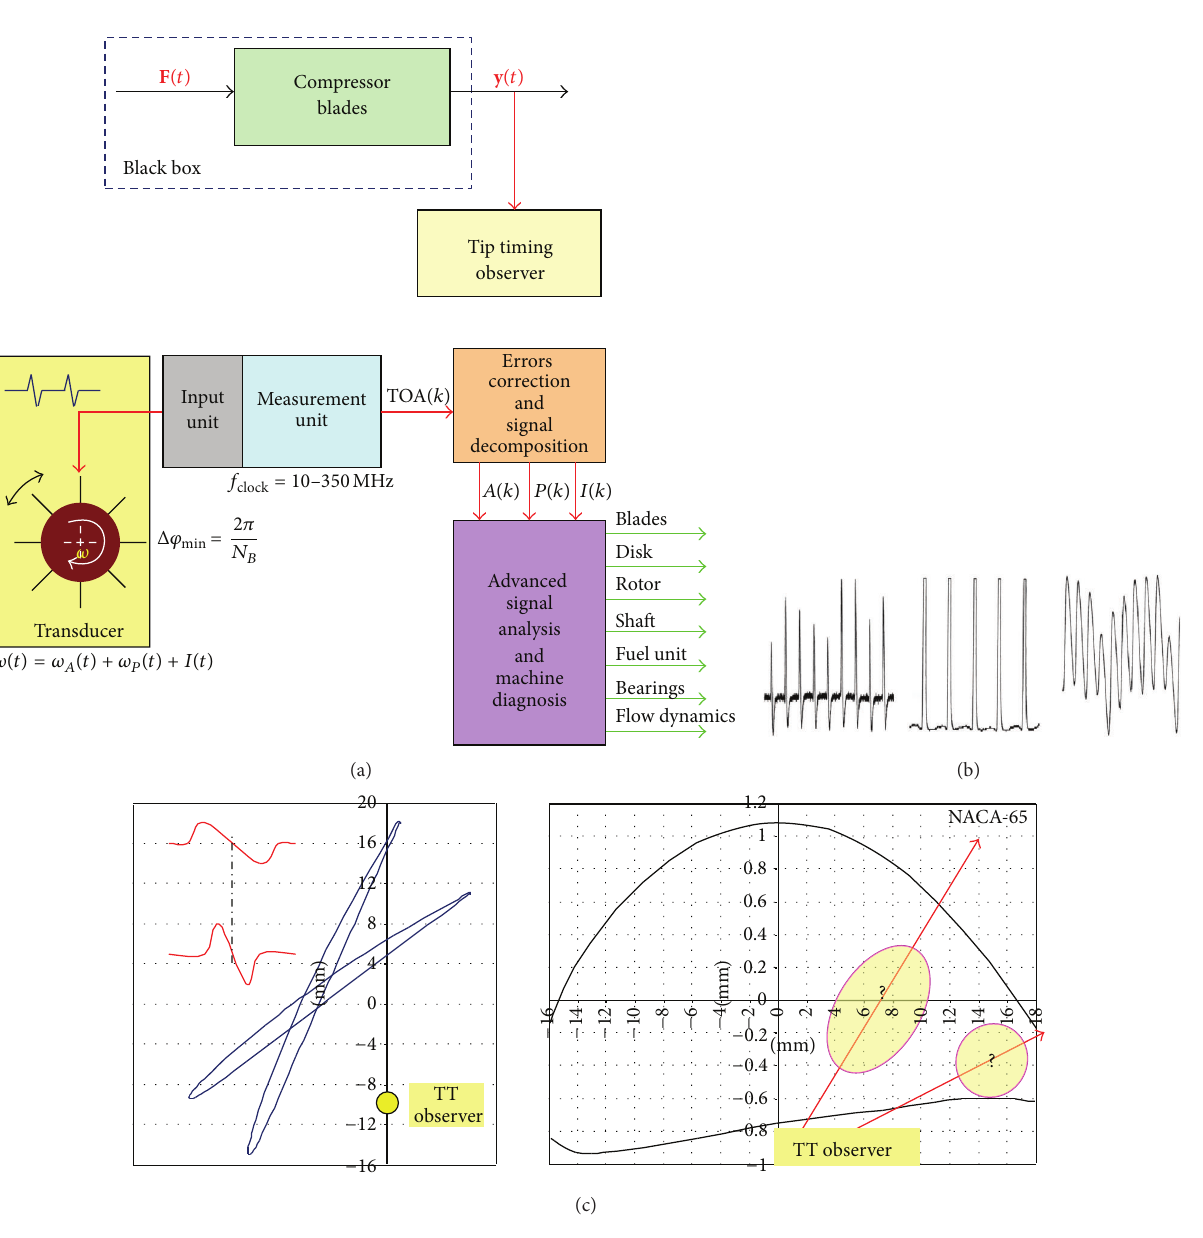
Figure 19: Showing (a) an idea and a block structure of the tip timing method; (b) a shape of analog signal for vary reluctance (VR), optical and eddy current (EC) sensor. Signal with VR and EC sensors also contains information about magnetizing blades; (c) main problem of VR and EC sensors—precise relation of the analog signal with putting the top of the blade with regard to the sensor (Where is the blade? Which point of the blade top is in the relation with the characteristic point of the analog signal?)